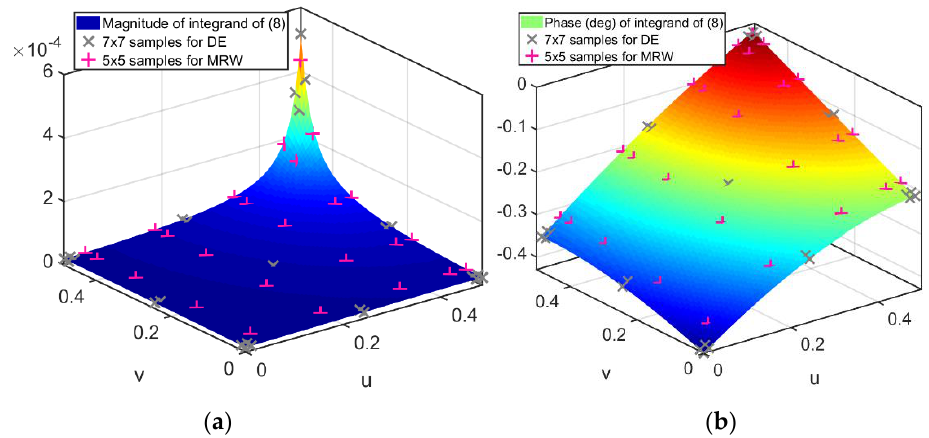
Figure 4. Magnitude ( a ) and phase ( b ) of the integrand of (8) in the integration domain given in region I for the decomposition shown in Figure 2. The values of the coordinates ‘ x ’ and ‘ y ’ of the observation point have been selected in order to satisfy the condition (9) when u obs = v obs = 0.485. Distribution of 7 × 7 DE samples and 5 × 5 MRW samples are also shown in the integration domain of region I.